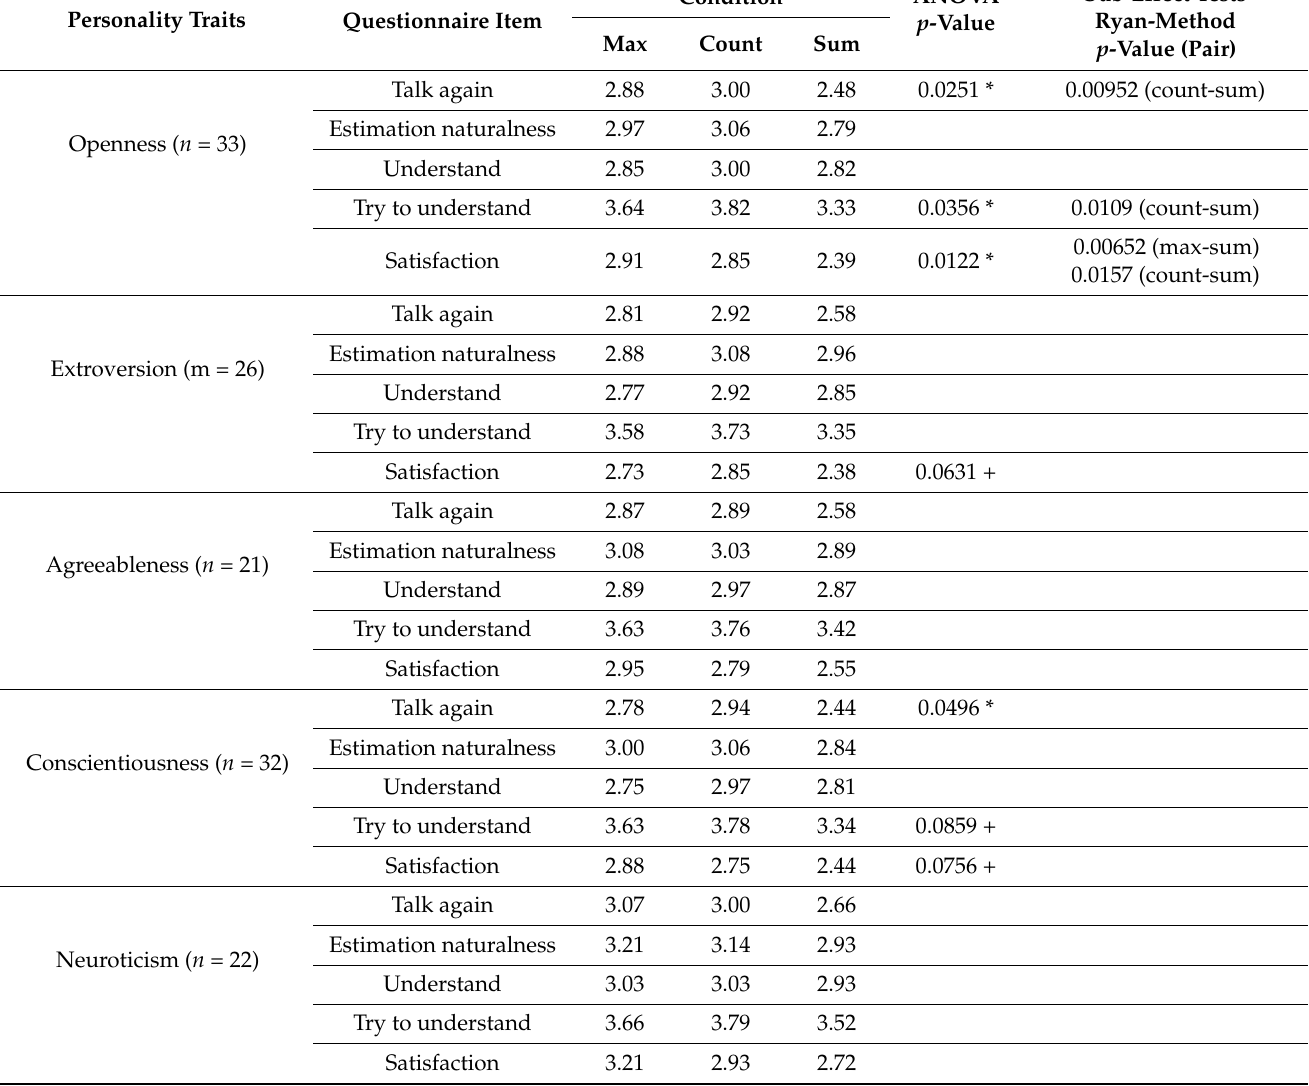
Table 8. Subjective evaluation of each dialogue